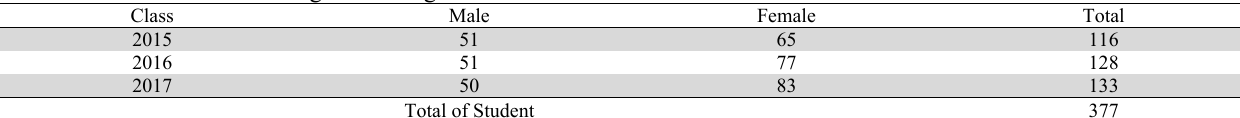
Data Student of Business/Management